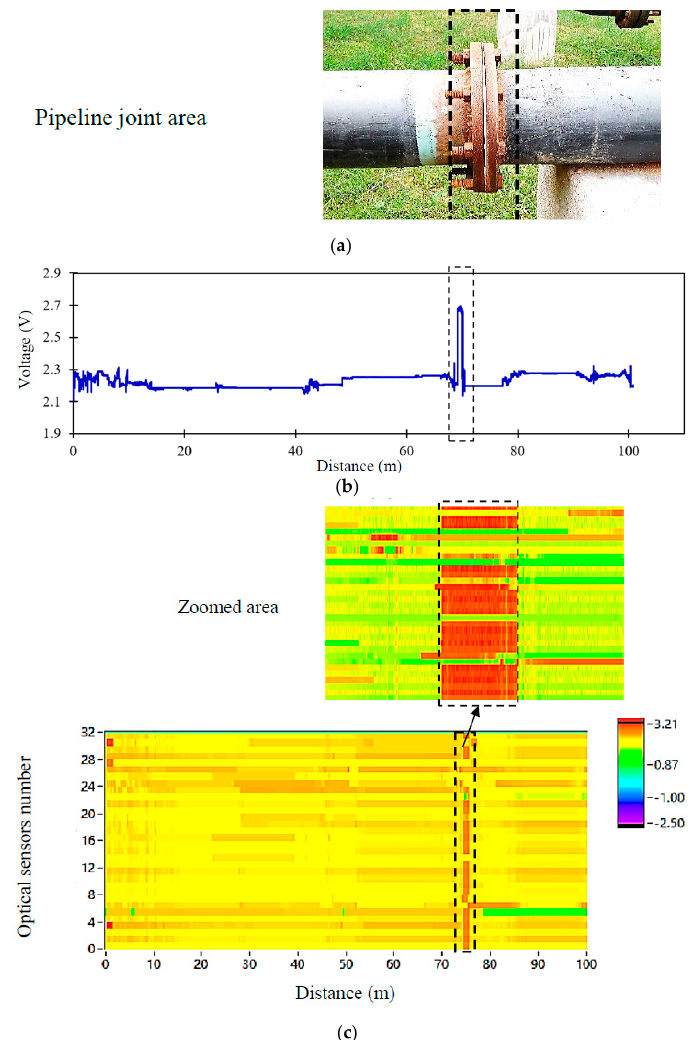
Figure 16. The results for the real-world application using the proposed method; ( a ) photo of the pipeline joint, ( b ) output voltage of the sensor for the whole pipe inspection, ( c ) 2D image of the scanned pipeline with zoomed abnormality area at a location between 70 m and 80 m.